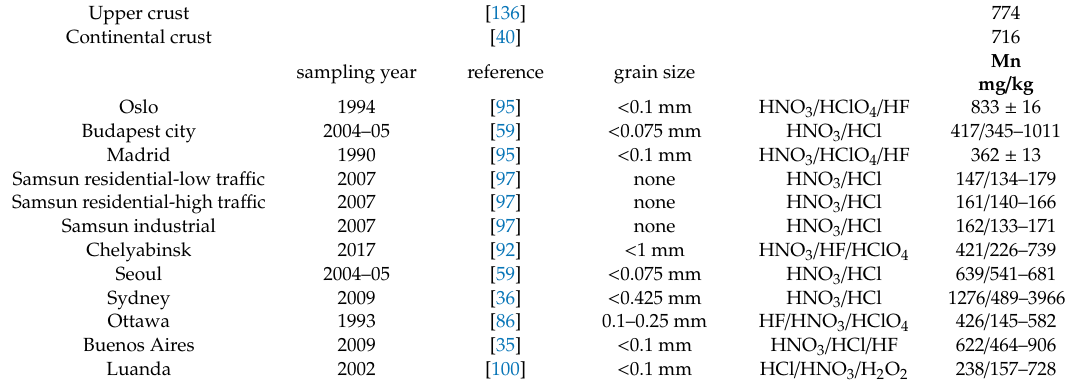
Table A31. Manganese in road